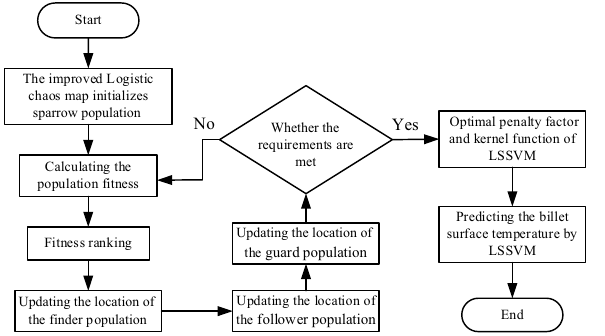
Figure 3. Flow chart of ILGSSA-LSSVM